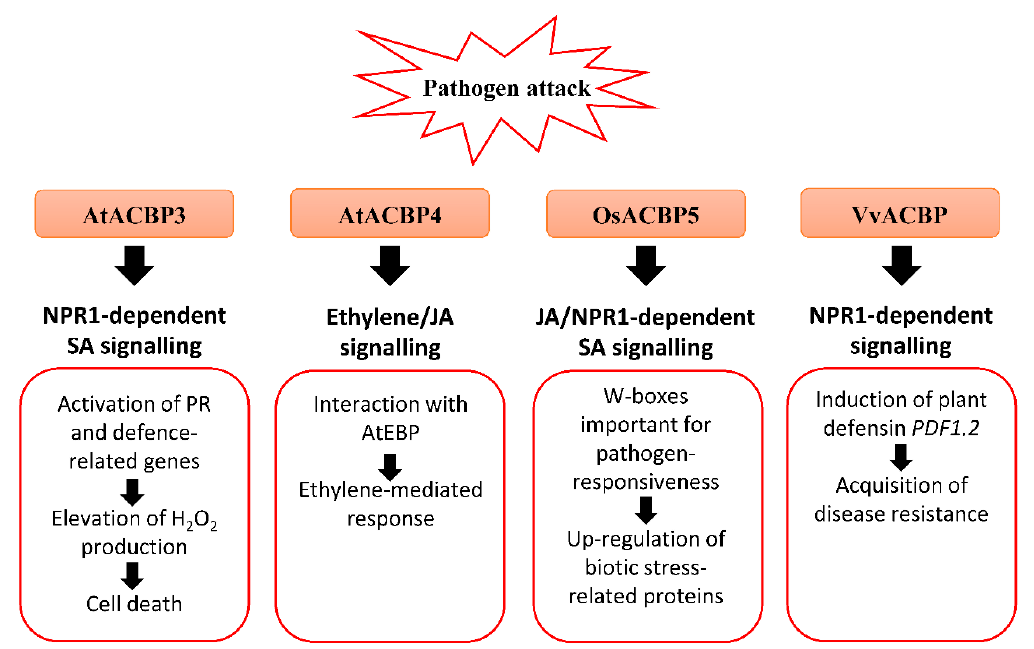
Figure 2. Biotic stress-related signalling pathways associated with acyl-CoA-binding proteins (ACBPs) in plants. Upon pathogen infection, the overexpression of Class III AtACBP3 in transgenic Arabidopsis thaliana led to constitutive activation of pathogenesis-related (PR) genes including PR1 , PR2 and PR5 , elevated H 2 O 2 production and eventually cell death [121]. AtACBP3 plays a distinct role in the plant defence response against necrotrophic and biotrophic pathogens as transgenic Arabidopsis AtACBP3-overexpressors (OEs) were protected against the biotrophic pathogen ( Pseudomonas syringae